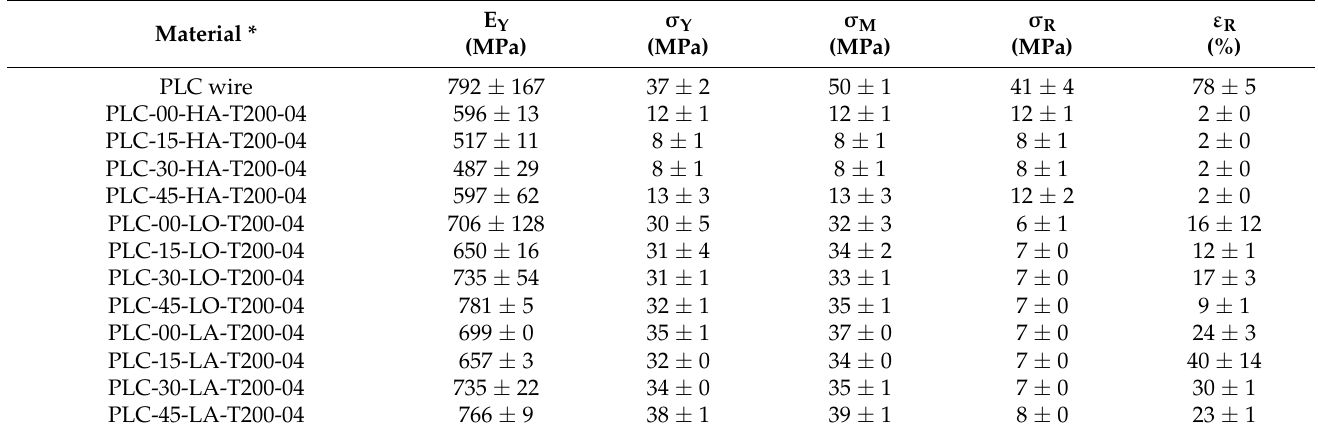
Table 3. Observed tensile performance of PLC according to printing